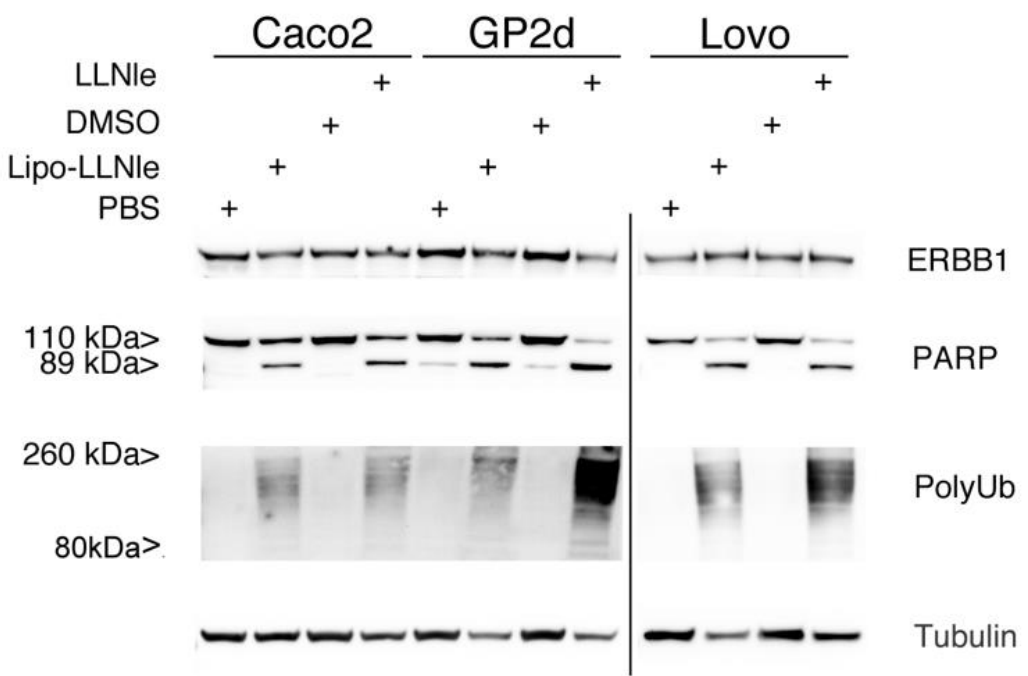
Figure 5. LLNle-liposome inhibits proteasomal degradation of poly-ubiquitinated protein and induces apoptosis in CRC cell lines. Immunoblot analysis of whole-cell lysates of Caco-2, GP2d, and LoVo cell lines treated with LLNle, DMSO (used as control for LLNle), LLNle-liposomes, and PBS (control for LLNle-liposomes) for 72 h. LLNle-liposomes were diluted to achieve an LLNle final concentration in the culture medium equivalent to 1.7, 1.4 and 0.6 µ M LLNle of free LLNle for Caco-2, GP2d and LoVo, respectively. All three cell lines display expression of ERBB1, the EGF receptor. A high molecular weight smear signal, corresponding to poly-ubiquitinated proteins, and the generation of the 89 kDa isoform of the protein PARP was detected by specific Ab only in LLNle-liposomes and LLNle treated samples. Tubulin was used as a loading control.